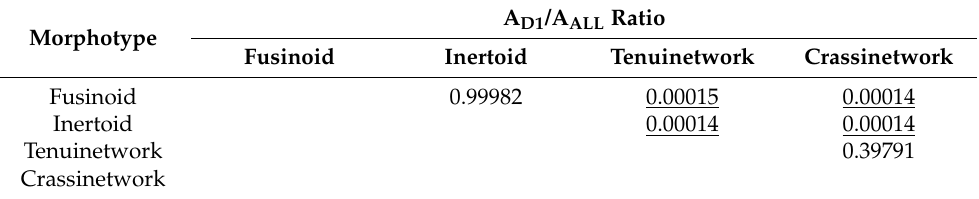
Table 12. Results of the Tukey’s HSD multiple comparison test for the A D4 /A ALL ratio. A D4 /A ALL Ratio Morphotype Fusinoid Inertoid Tenuinetwork Crassinetwork Fusinoid 0.62918 0.00031 0.00014 Inertoid 0.00014 0.00014 Tenuinetwork 0.47441